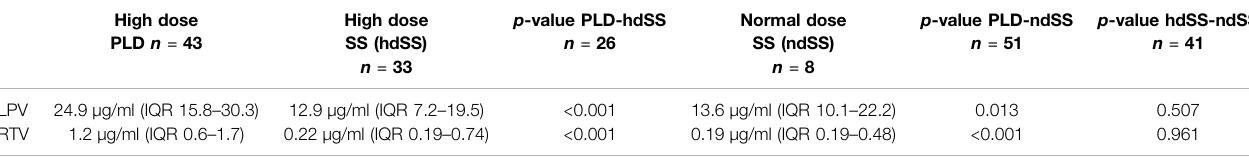
High dose SS (hdSS)